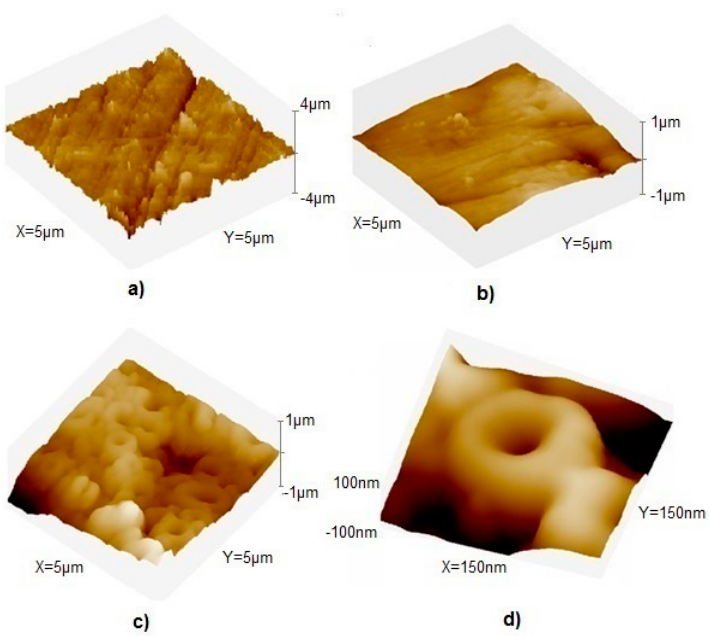
Figure 3. Atomic Force Microscope (AFM) images of the surface topography. ( a ) Substrate titanium alloy; ( b ) alloy after EO1 treatment; ( c ) alloy after EO1 + EO2 treatment; ( d ) a single nanotube. Table 2. Roughness parameters ( R a ) in the area of 200 × 200 nm 2 .